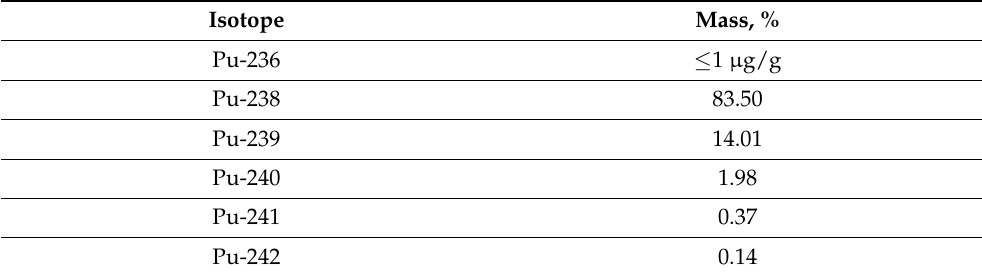
Table 1. Isotope composition of plutonium from Savannah River Site (Aiken, SC, USA). Isotope Mass,